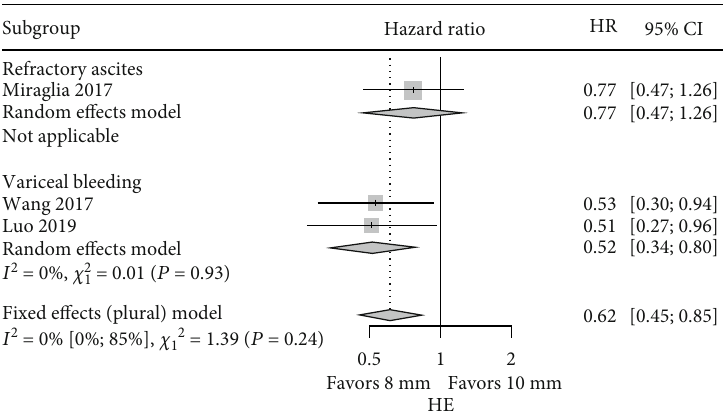
Figure 5: Subgroup meta-analysis of HR of HE in variceal bleeding and refractory ascites: 8mm vs. 10mm. Subgroup